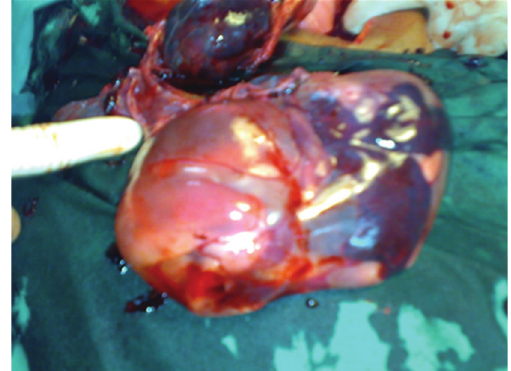
Figure 2: Fetus with intact sac.